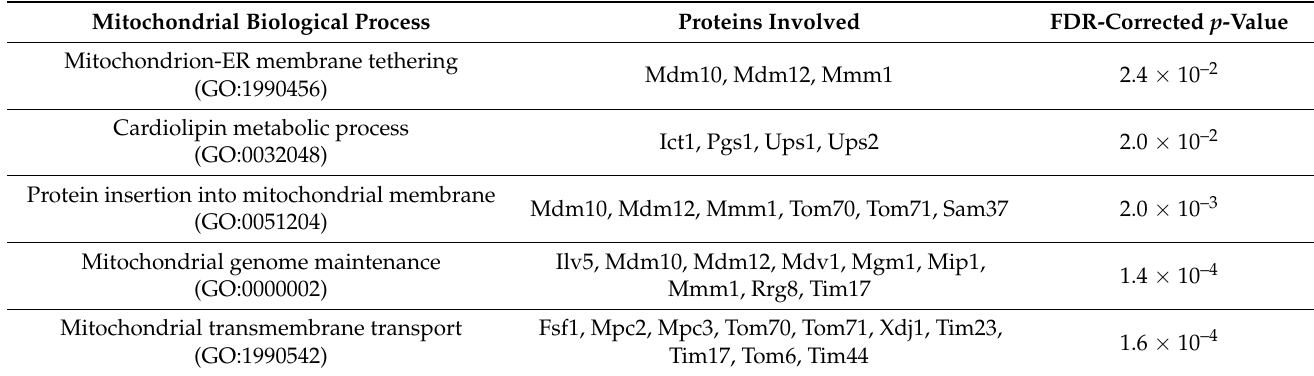
Table 1. Mitochondrial processes affected by proteins that increase in abundance in yme1 mutant mitochondria.